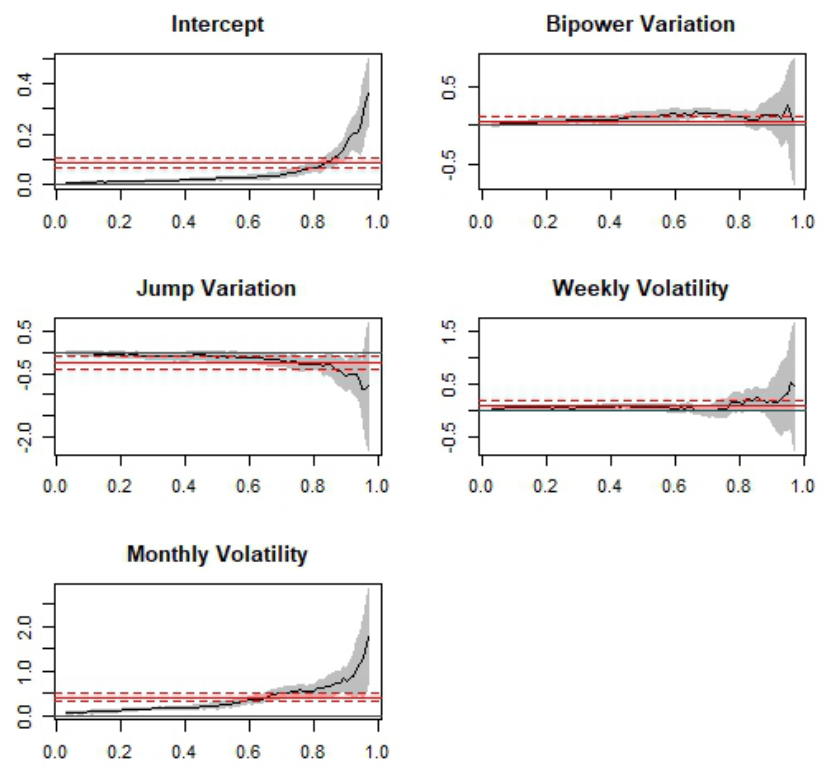
Figure 6. Model 4: HAR-RV-QR results—7-day